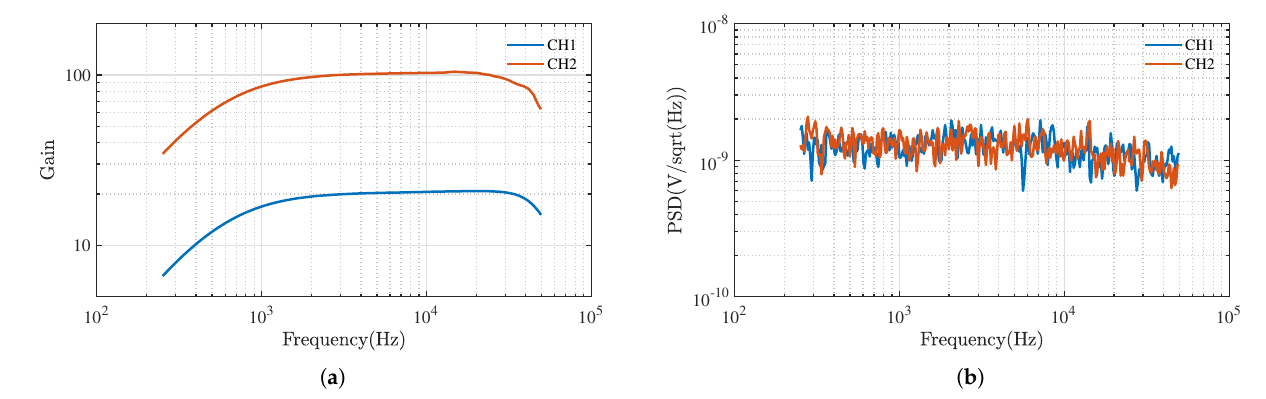
Figure 9. Performance of the analog signal conditioning module. ( a ) Gain; ( b ) power density of equivalent input